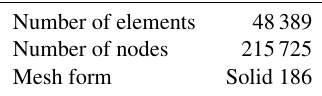
Table 9. Finite element model parameters of the frame.